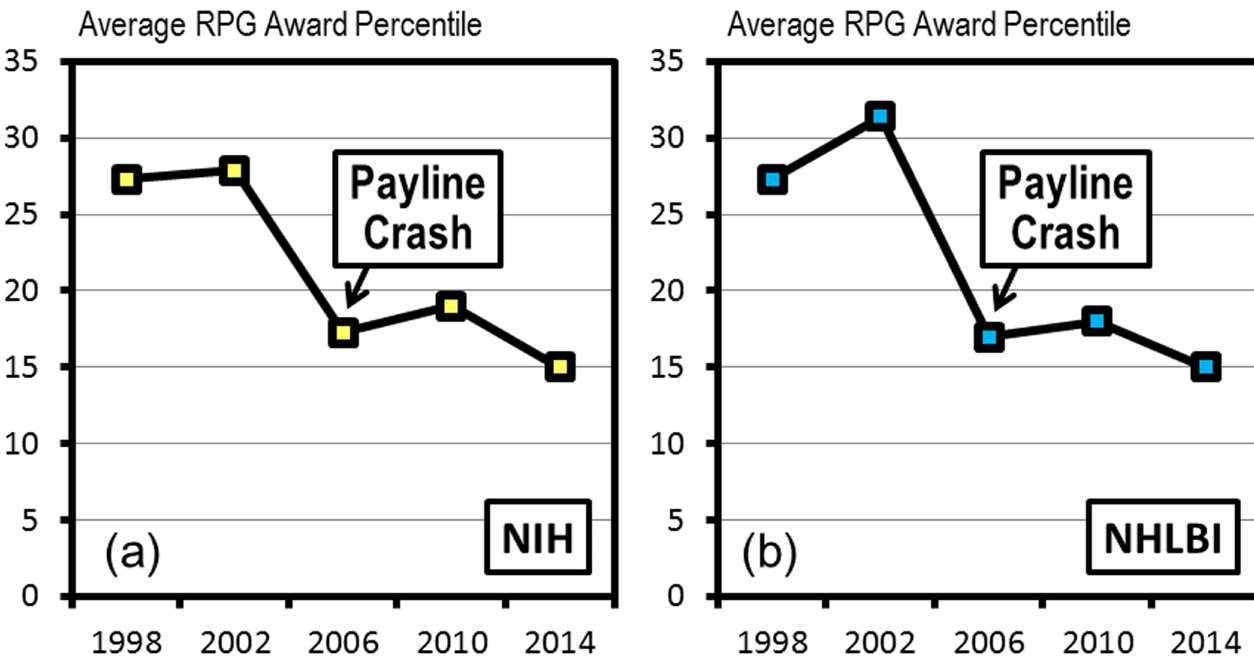
Fig 2. The Percentile Payline Crash of 2006. Average aggregatepaylinepercentiles,for those RPG grant mechanisms that were percentiled, for select years between1998 and 2014 at (a) NIH and (b) NHLBI.